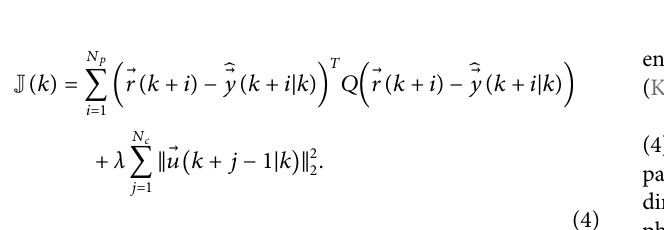
FIGURE 3 | Sparsity-promoted closed-loop control of the heart rate (HR) and the mean arterial blood pressure (MAP) of the in silico physiological model of the rat cardiacsystem. (A) and (B) showtheclosed-loopcontrolresponsefromthe insilico physiologicalmodel(showninreddots)andthetarget(orreference)forthecontroller (showninblack line)forHRand MAP, respectively. (C) and (D) showthepulse width and thestimulation frequency,respectively, designed bythecontroller ateach VNS location.